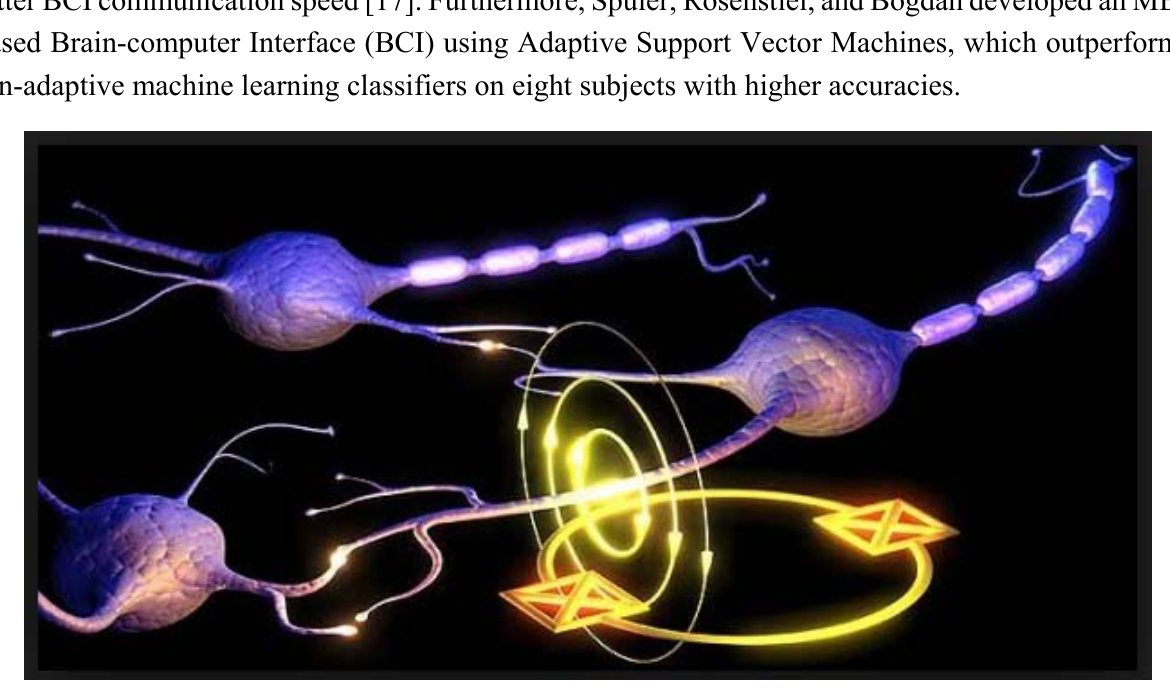
Figure 1. Superconducting Quantum Interference Devices